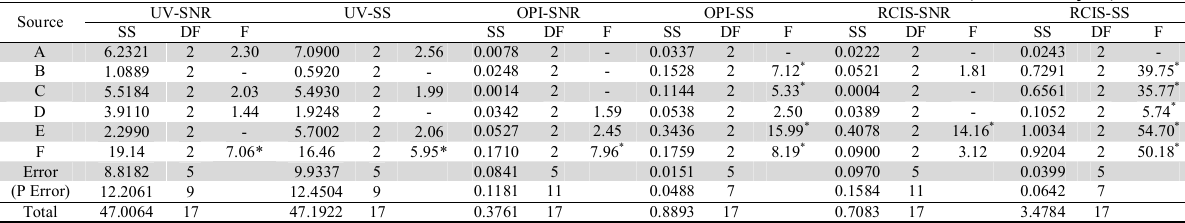
ANOVA results on UV-SRN, UV-SS, OPI-SNR, OPI-SS, RCIS-SNR and RCIS-SS (case study 2) Source UV-SNR